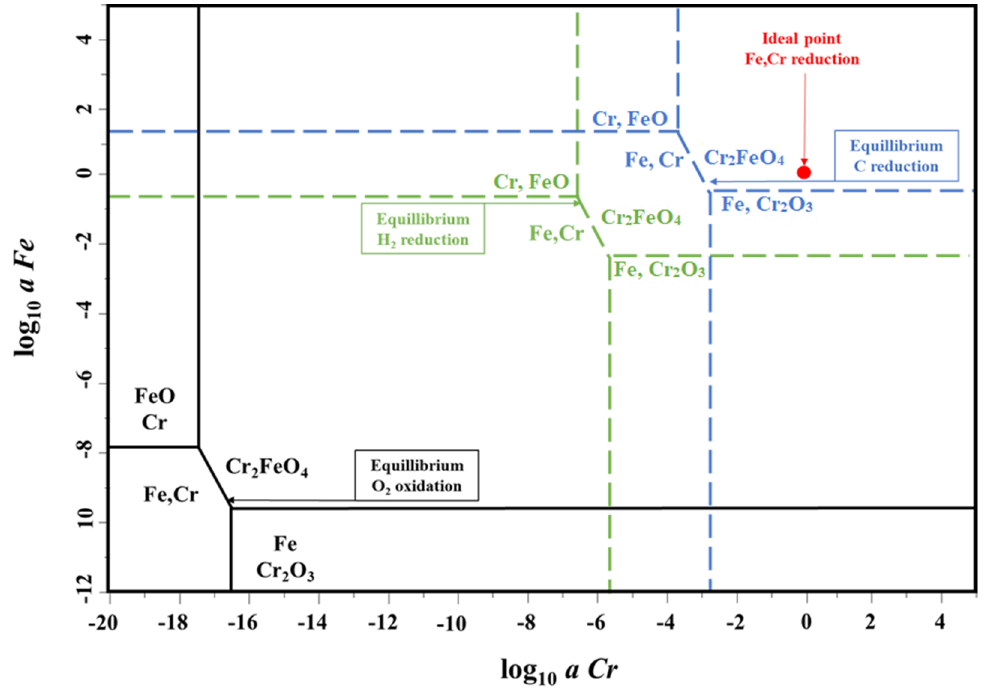
Figure 1. Phase stability diagrams of the (Cr, Fe)-C-H-O system as a function of partial pressure of H 2 and H 2 O at a temperature of 1000 ◦